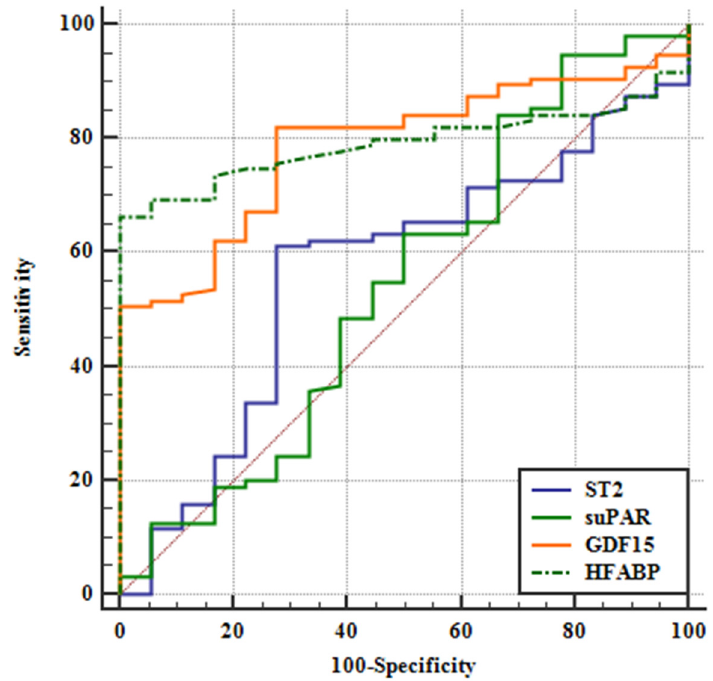
Figure 1. Comparison of biomarker levels between control group, HFpEF, ICM, and DCM patients (median + IQR).